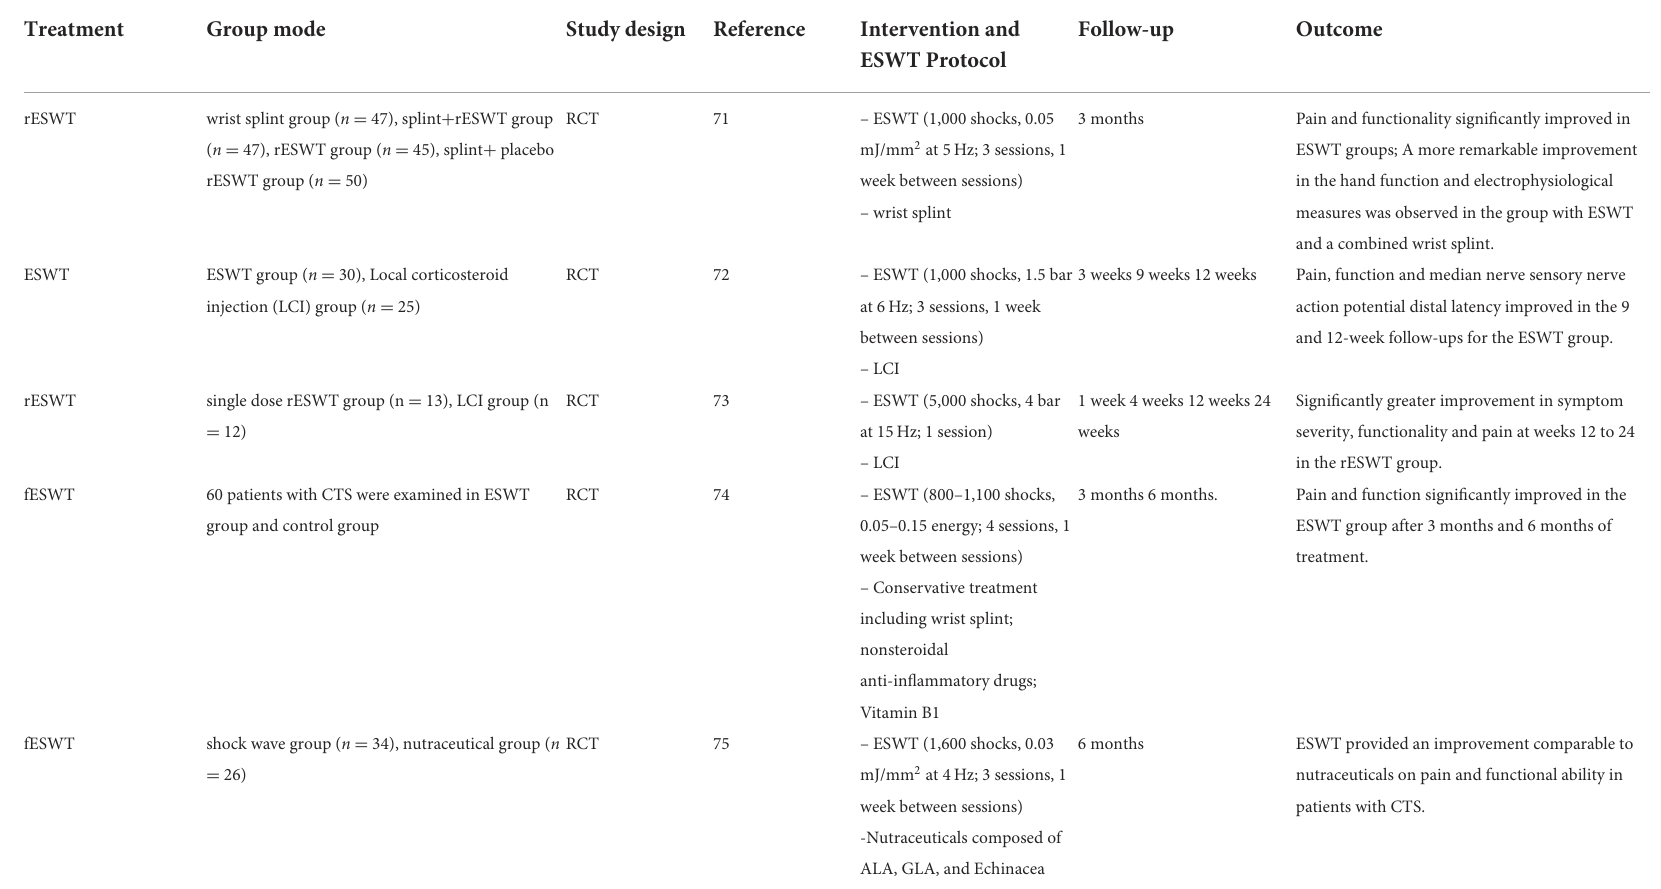
TABLE 1 Summary of the applications of ESWT in